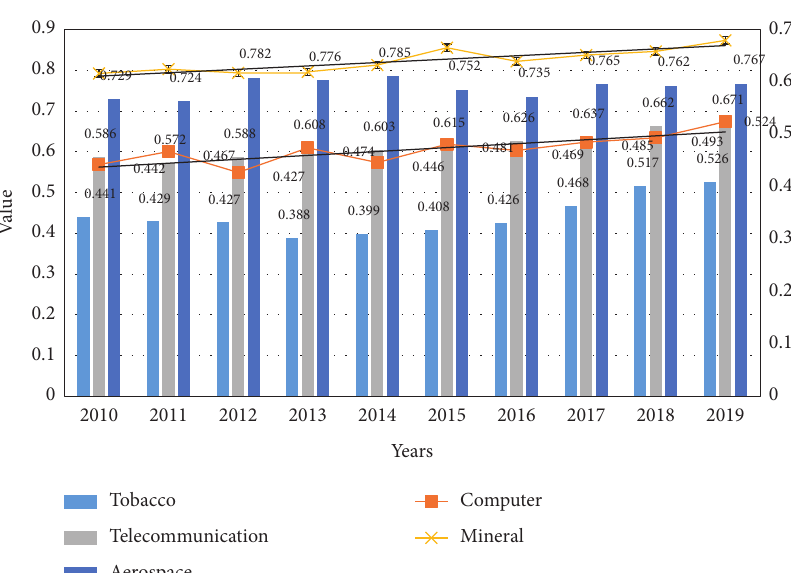
Figure 7: Simulated innovative green industry value.